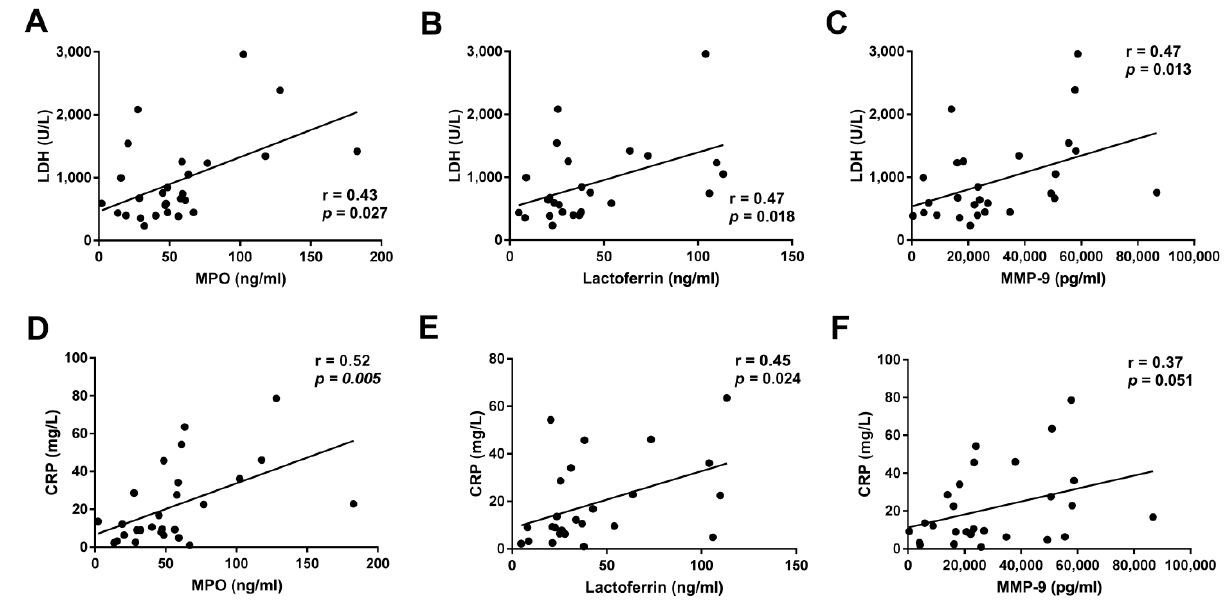
Figure 4. Correlation between paraclinical parameters and the pleural concentration of neutrophil- derived products in LAC patients with MPE. Positive correlation between ( A–C ) LDH (U/L) or ( D–F ) CRP (mg/L) and levels of MPO (ng/mL), lactoferrin (ng/mL) and MMP-9 (pg/mL). R and p values were calculated using Spearman’s correlation coefficient.